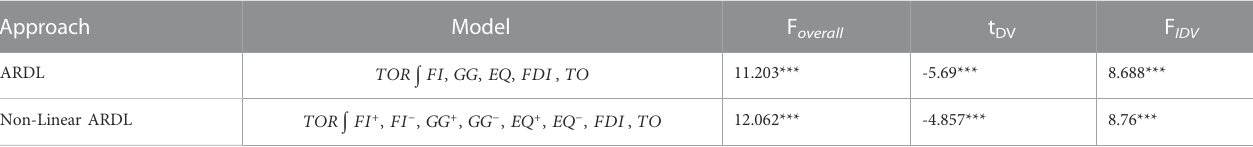
TABLE 7 Results of long-run cointegration-linear and non-linear framework.